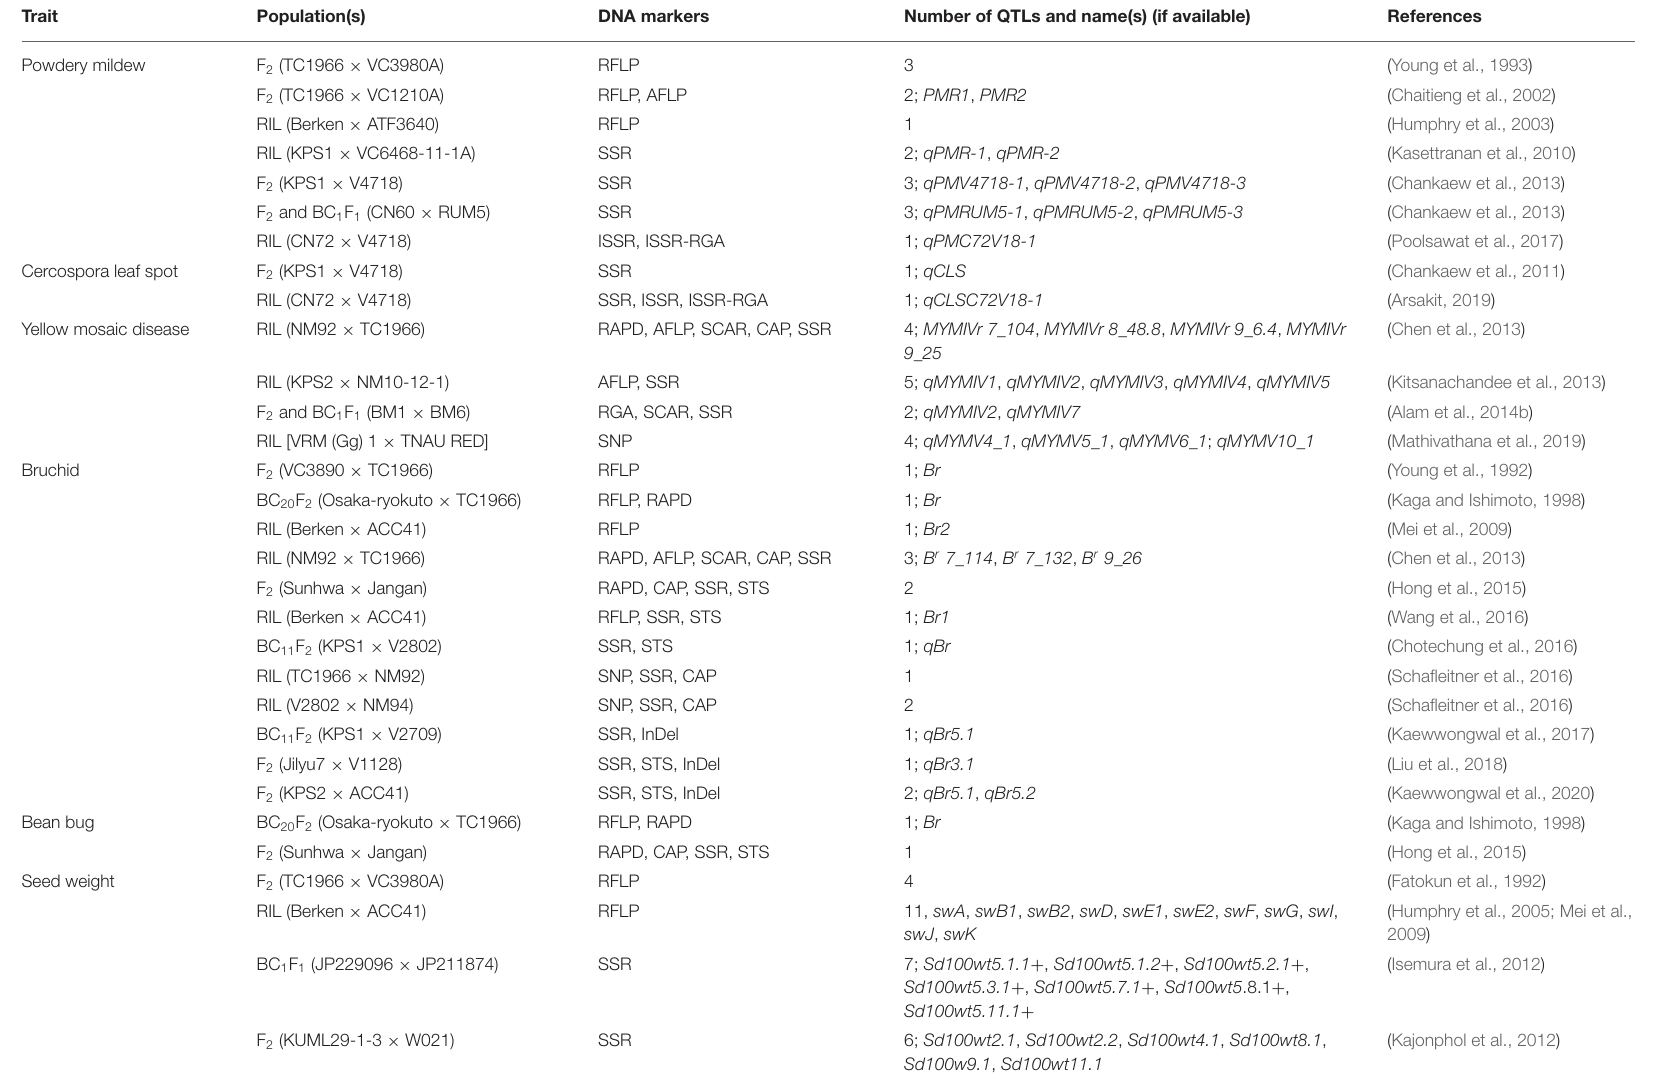
TABLE 1 | Quantitative trait loci identified for various traits in mungbean by gene mapping using experimental populations. Trait